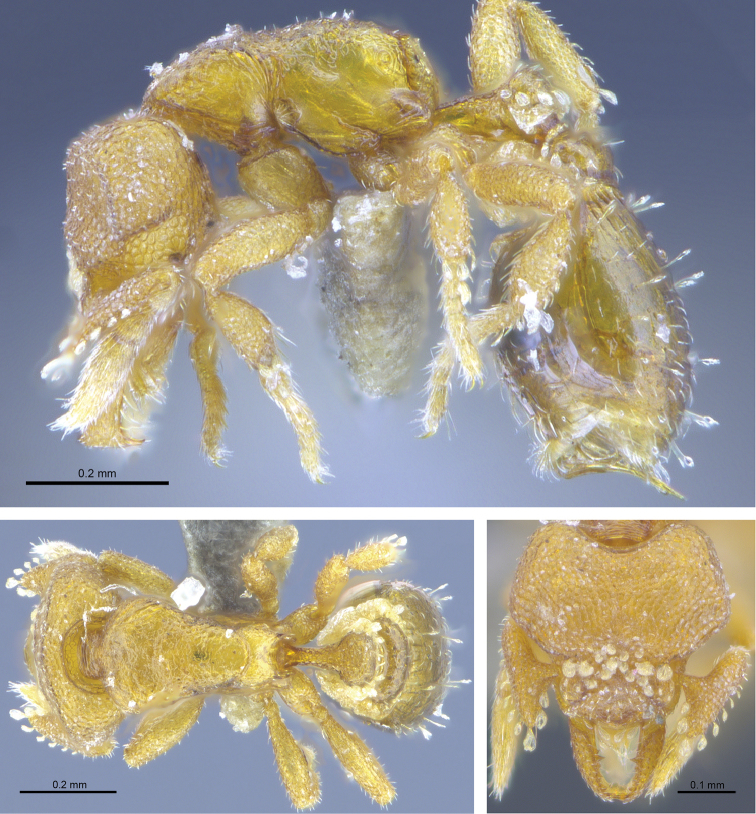
StrumigenysformosaA–C worker (RHL003476) A profile view B dorsal view C full-face view.